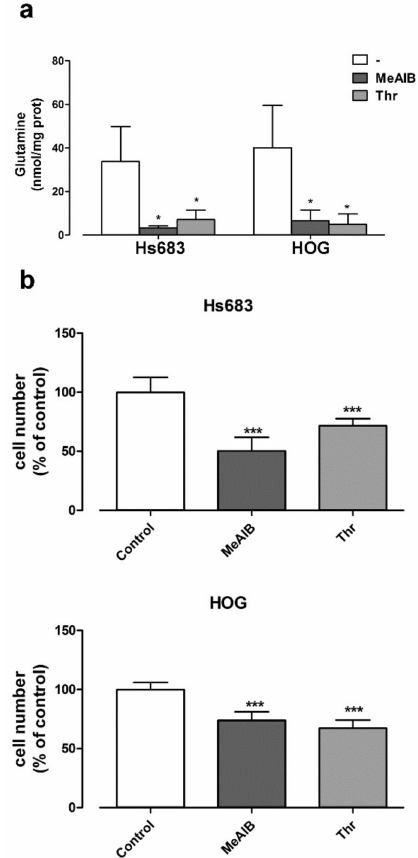
Figure 8. Inhibitors of Gln transporters have anti-proliferative effects on oligodendroglioma cells. Hs683 and HOG cells were incubated in growth medium in the absence (Control) or in the presence of MeAIB (20 mM) or Thr (20 mM). ( a ) After 9 h, the cell content of Gln was measured. Data are expressed as nmol/mg prot. ( b ) After 72 h, the cell number was evaluated. Data are expressed as % of control (standard growth medium). In both panels, data are means ± SD of three experiments with three independent determinations each. * p < 0.05, *** p < 0.001, as assessed with two-tail student t test for unpaired